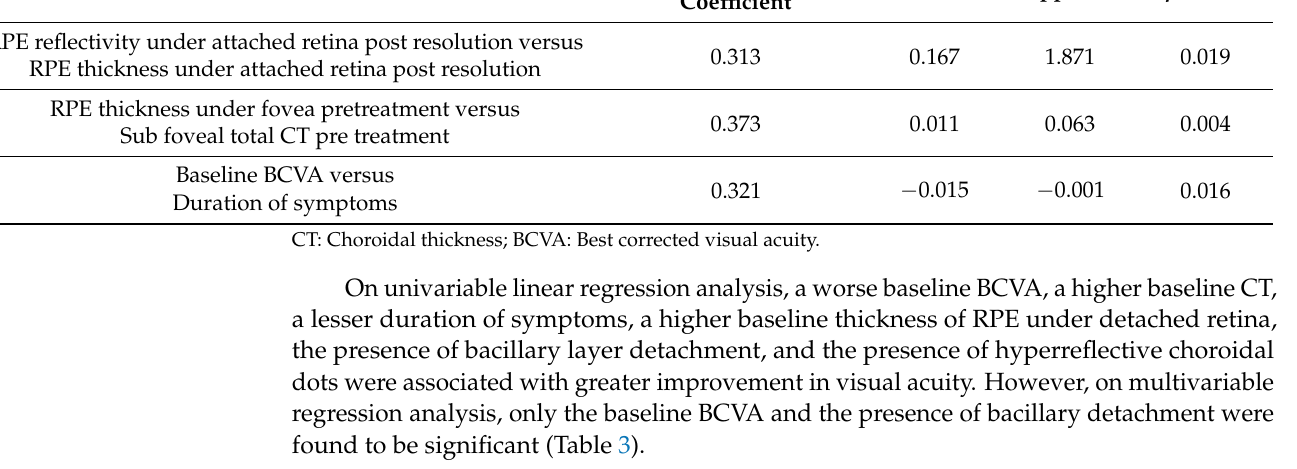
Table 3. Linear regression analysis showing factors affecting change in visual